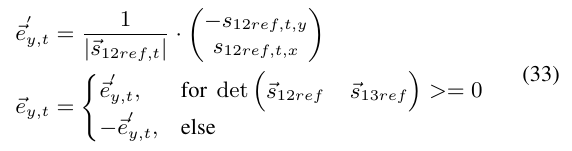
r algorithm 1 = crack width with algorithm 1 r algorithm 2 = crack width with algorithm 2